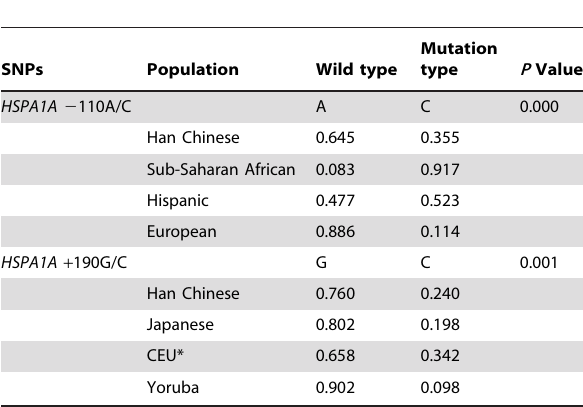
Table 1. Comparison of Allele Frequencies of Polymorphisms in HSPA1A genes among Different Populations